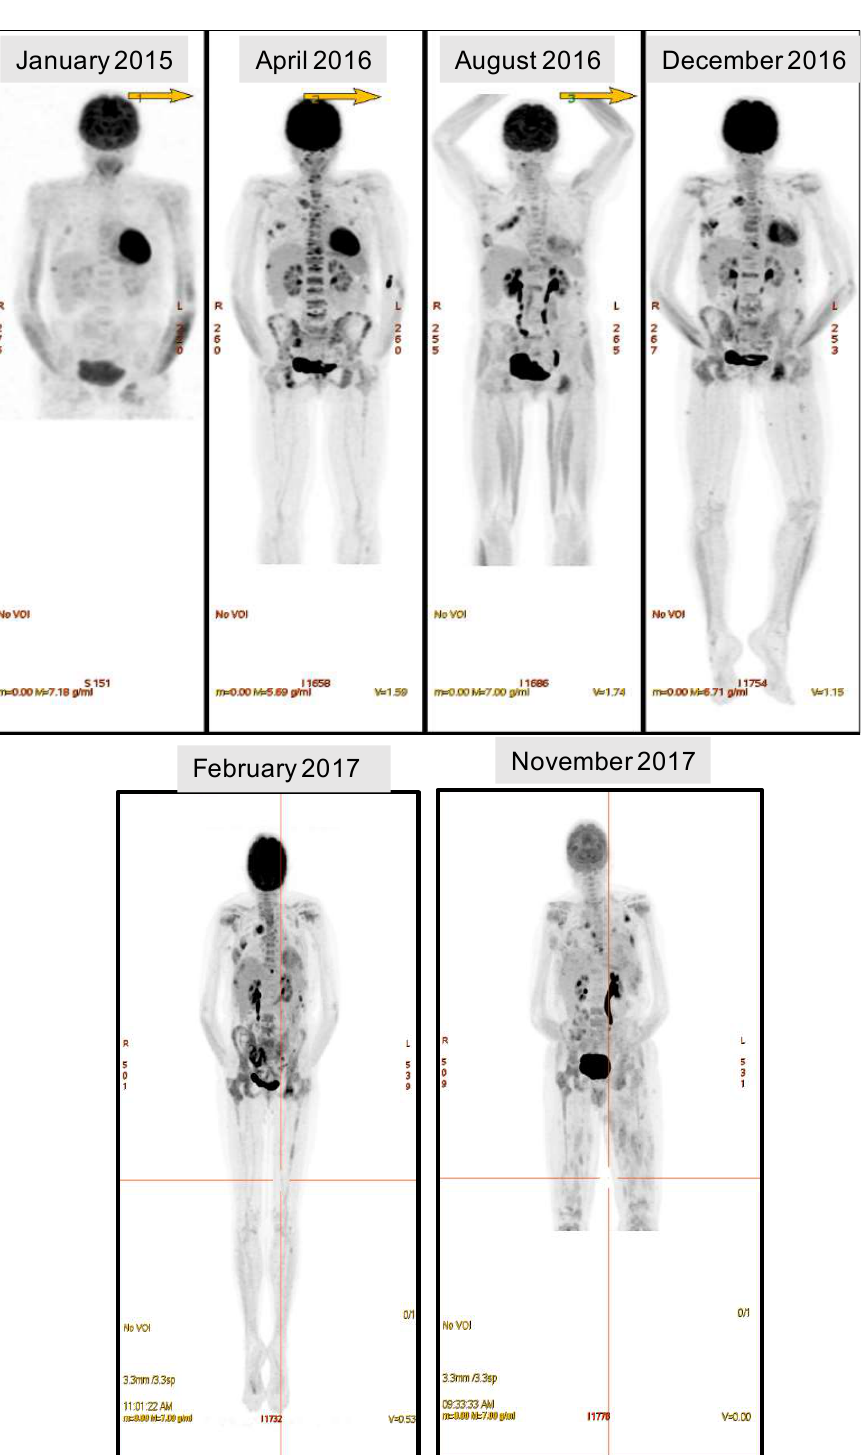
Figure 1. Progression of disease. Positron Emission Tomography (PET) images indicate the progression of disease in the extramedullary (EM)-sites with relative response to treatment in the bone marrow (BM).